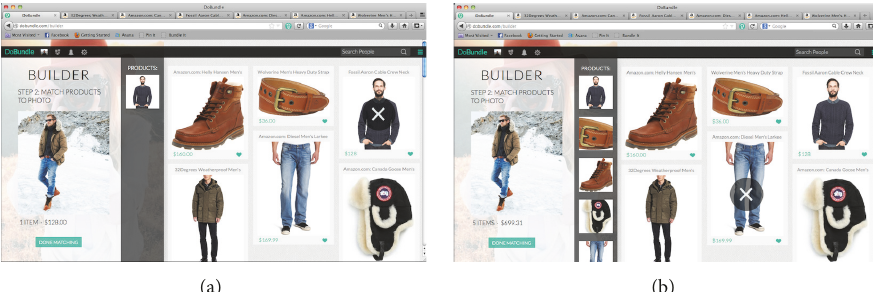
Figure 7: Associating products with Hook photo. (a) User matching 1 st product to their image. (b) User matching 6 th product to their image.